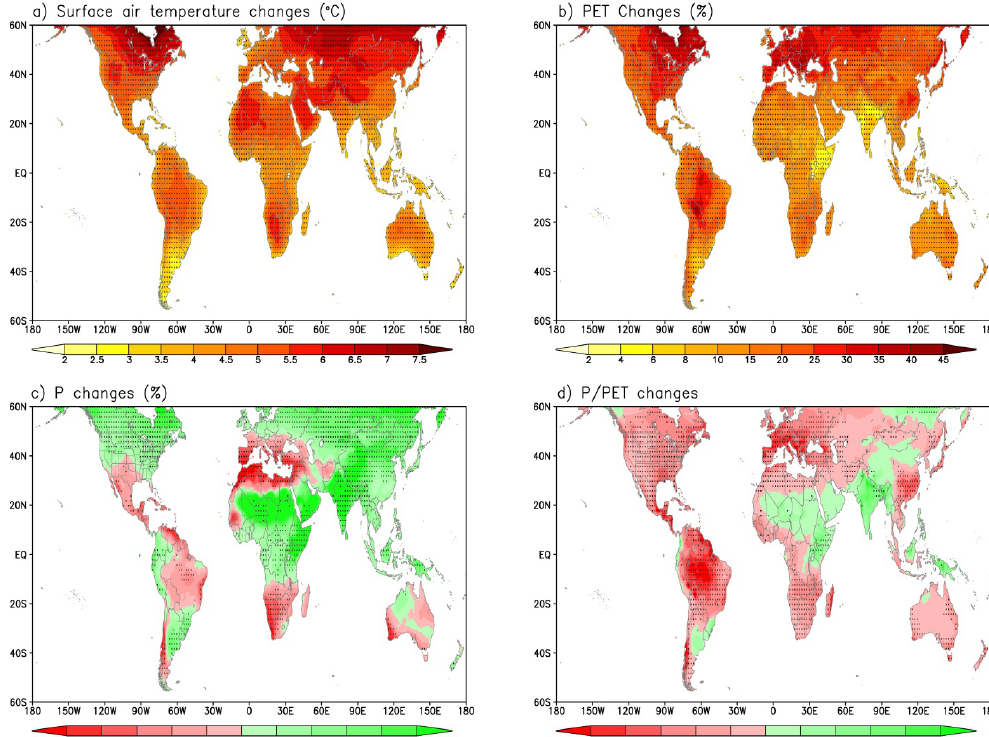
Fig. 7. Projected changes in (a) surface air temperature ( ◦ C), (b) PET (%), (c) precipitation (%), and (d) P /PET for 2071–2100 relative to 1961–1990 under scenario RCP85 from 27 climate models. Grid points are stippled where more than 80% of these models agree on the sign.